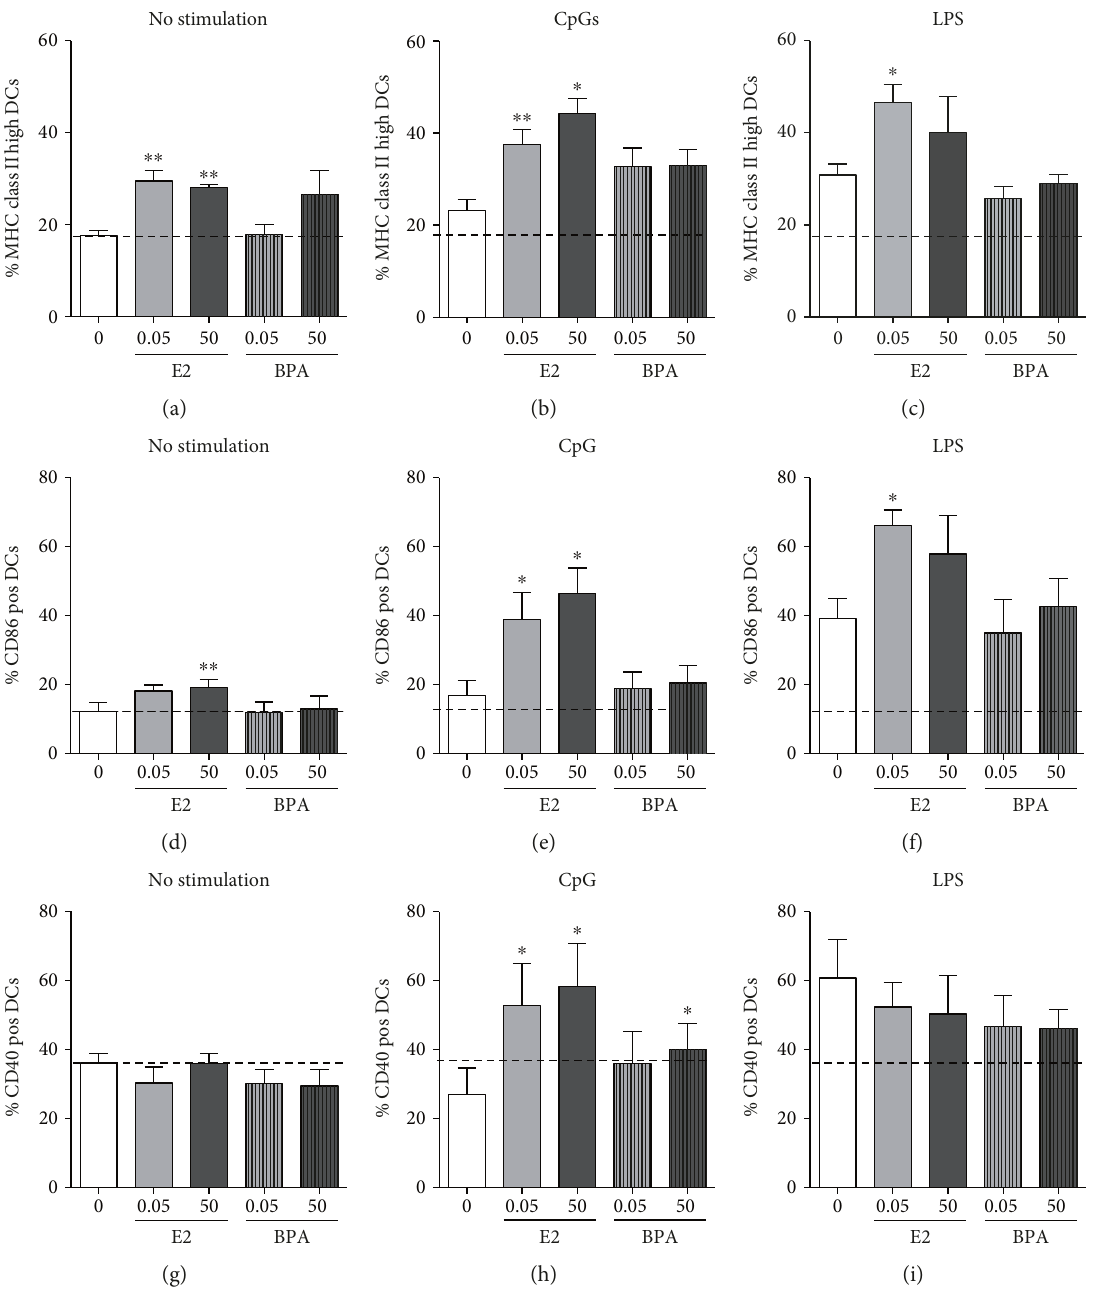
Figure 4: Estrogen but not BPA upregulates the expression of costimulatory molecules upon stimulation with CpG and LPS. (a – i) We grew cDCs in the absence or presence of low (0.05 nM) and high doses (50 nM) of E2 or BPA for 6-7 days. We then stimulated cDCs with either 100ng/mL of LPS (c; f; i) or 10 μ g/mL of CpG (b; e; h) as described in Figure 2 and analyzed the percentages of cDCs (gated for CD11c+ cells) positive for the indicated costimulatory and MHC molecules, 24 hours post stimulation with TLR ligands. Results are averages and SE of four BMDC cultures. Dotted lines indicate baseline expression in unstimulated cDCs grown in the absence of E2 or BPA; pos indicates positive. For each costimulatory or MHC molecule, we calculated statistical signi fi cance by one-way ANOVA and post hoc multiple comparison test against 0 condition (no E2 nor BPA). ∗ represents p < 0 05 , ∗∗ for p < 0 01 , and ∗∗∗ for p < 0 001